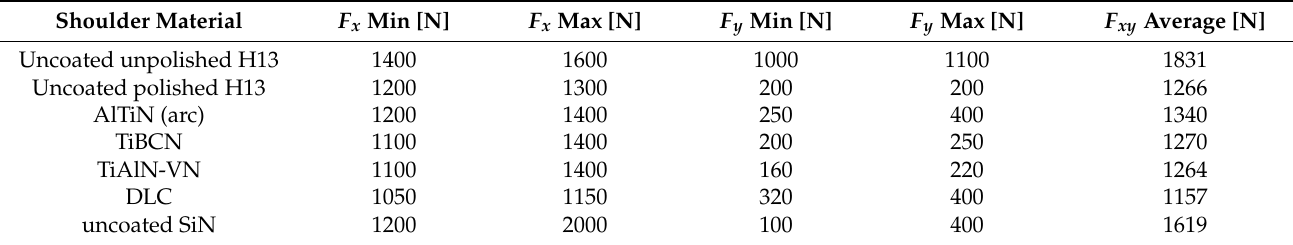
Table 3. Traverse ( x ) and side ( y ) forces associated with SS-FSW of 6 mm thick AA6082-T6 plate using SS-FSW tools comprising an H13 probe with the shoulders